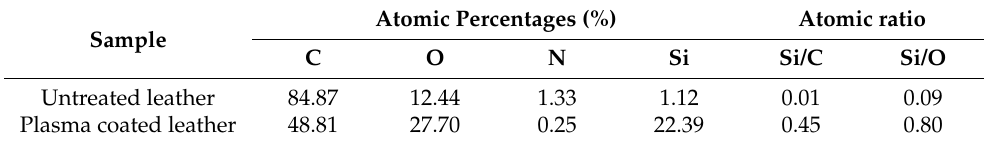
Table 4. Elemental compositions of untreated and HMDSO plasma deposited leather